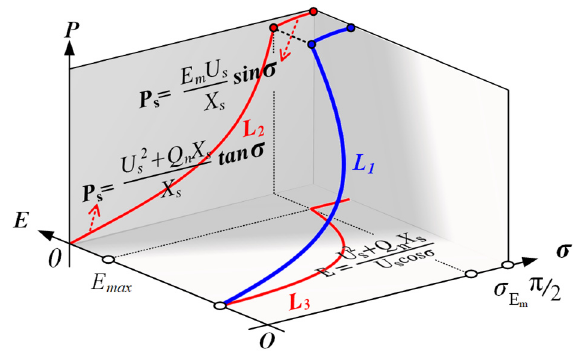
Figure 6. The relations of excitation voltage, stator active power, and power angle.